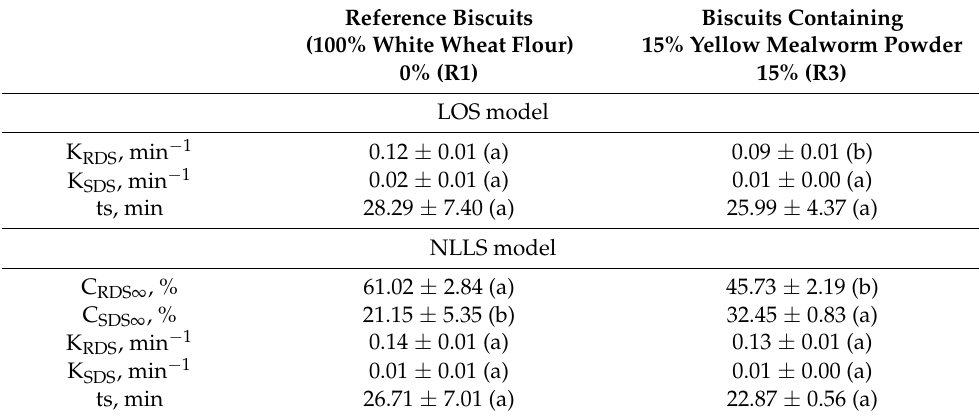
Table 6. Average values of the parameters associated with kinetic equations describing the digestion of RDS and SDS fractions subjected to application of LOS and NLLS kinetic